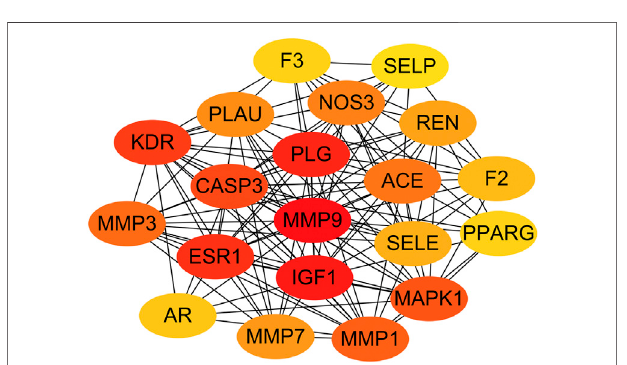
FIGURE 6 | Top 20 hub genes.